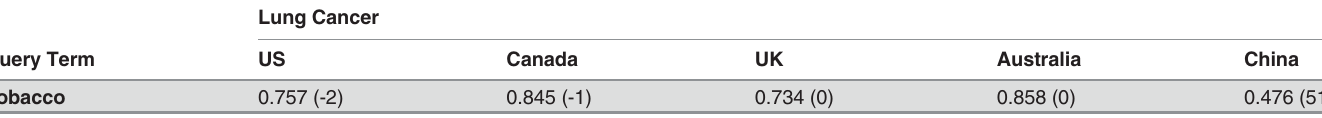
Table 3. The cross-correlations between seasonal components of search trends regarding tobacco and those regarding lung